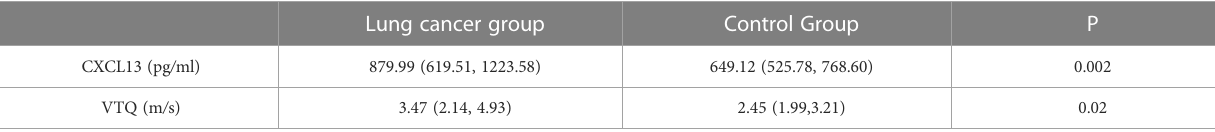
TABLE 2 The CXCL13 expression results and VTQ results from the two groups.